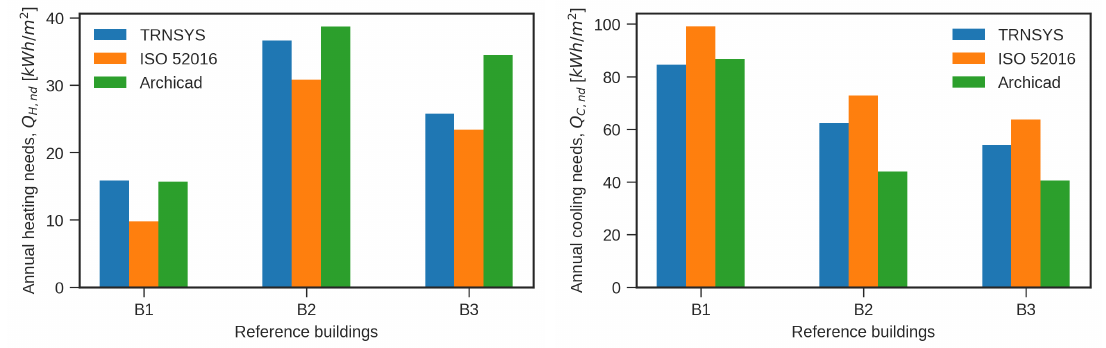
Figure 11. Annual heating and cooling needs for analyzed buildings in continental climate for three types of energy simulation: TRNSYS ( blue ), ISO 52016-1:2017 (ISO 52016, orange ), and Archicad Energy Evaluation tool (Archicad, green ).